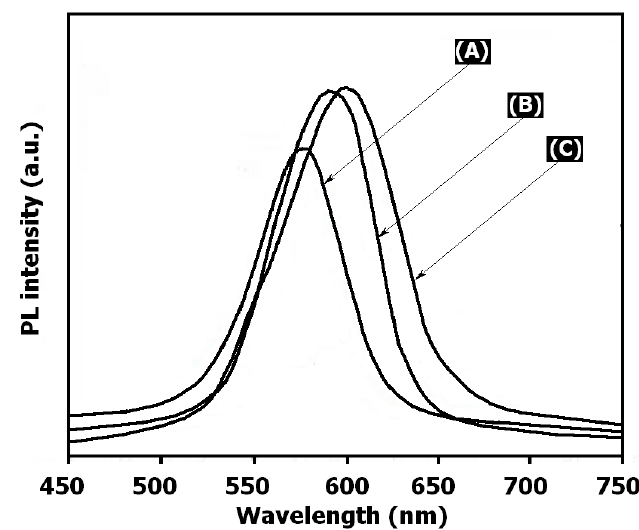
Figure 6. Photoluminescence (PL) spectra (excited at 380 nm) of ( A ) CdTe-OH QDs, ( B ) PPEGMA- g -CdTe, and ( C ) Ado- i -PPEGMA- g -CdTe nanohybrids.